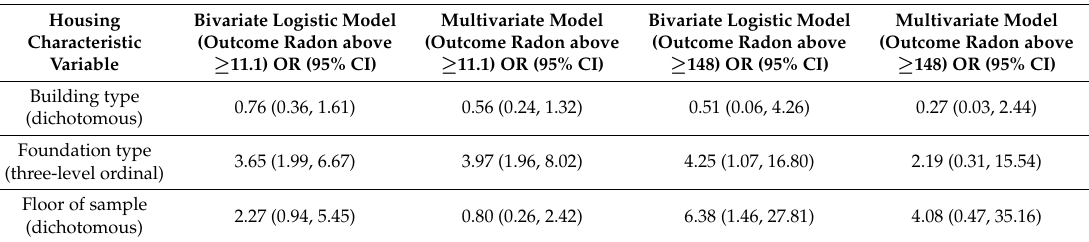
Table 3. Bivariate and multivariate logistic regression assessing housing characteristics and radon in homes in DeKalb County,